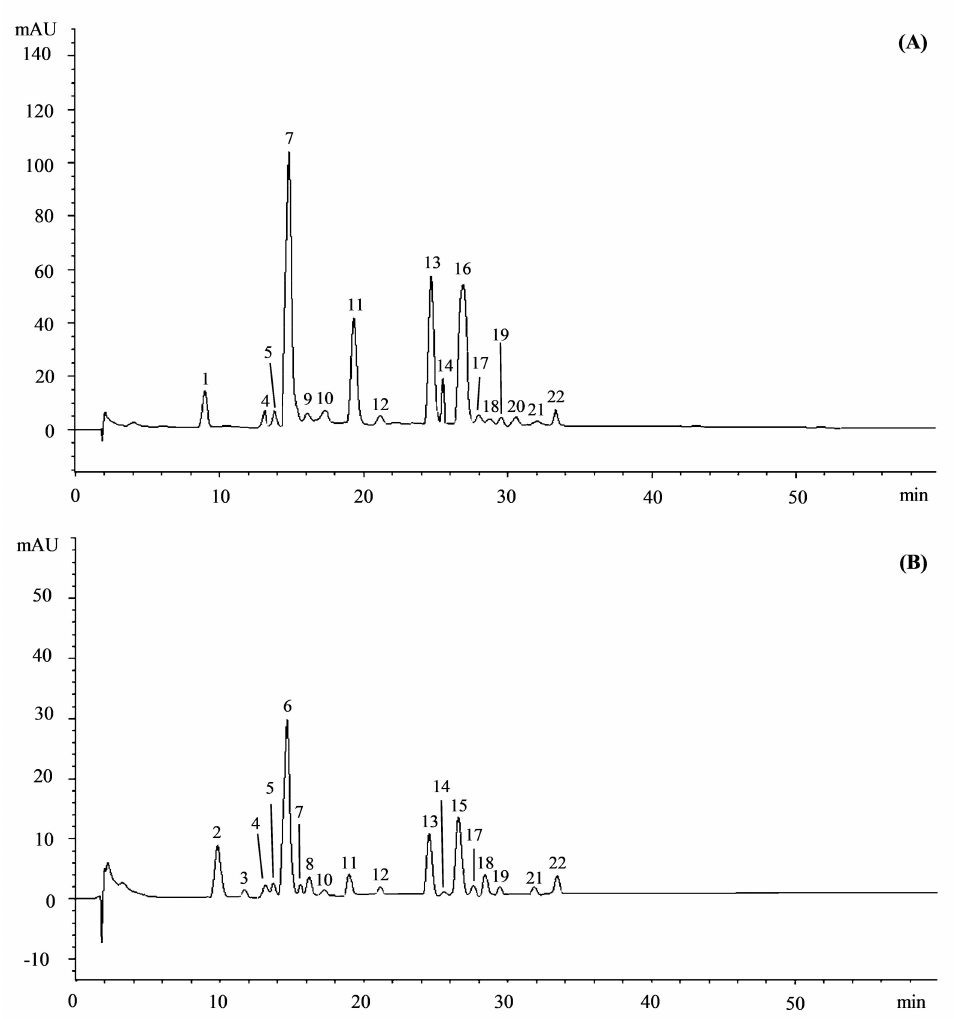
Figure 1. Representative LC-DAD chromatograms of O. europea L. var. sativa (OESA, panel A ) and O. europea var. sylvestris (OESY, panel B ) leaf hydroalcoholic extracts acquired at 254 nm. Peak numbers refer to the compounds listed in Table